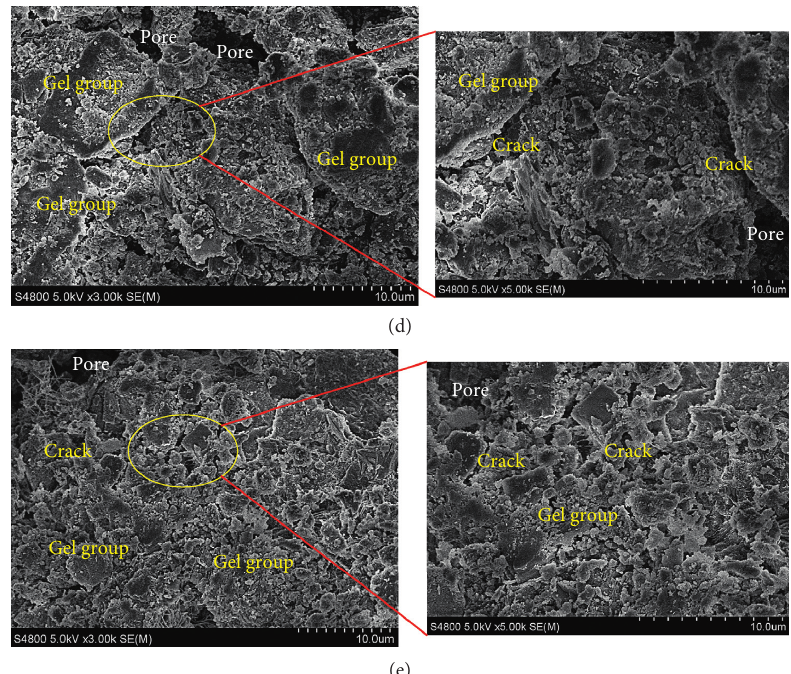
Figure 9: Mesomorphological and mineral crystal analysis of GTC (0% to 40%) based on SEM (power, 1.0 k to 5.0 k). (a) GTC-0; (b) GTC- 10; (c) GTC-20; (d) GTC-30; (e)